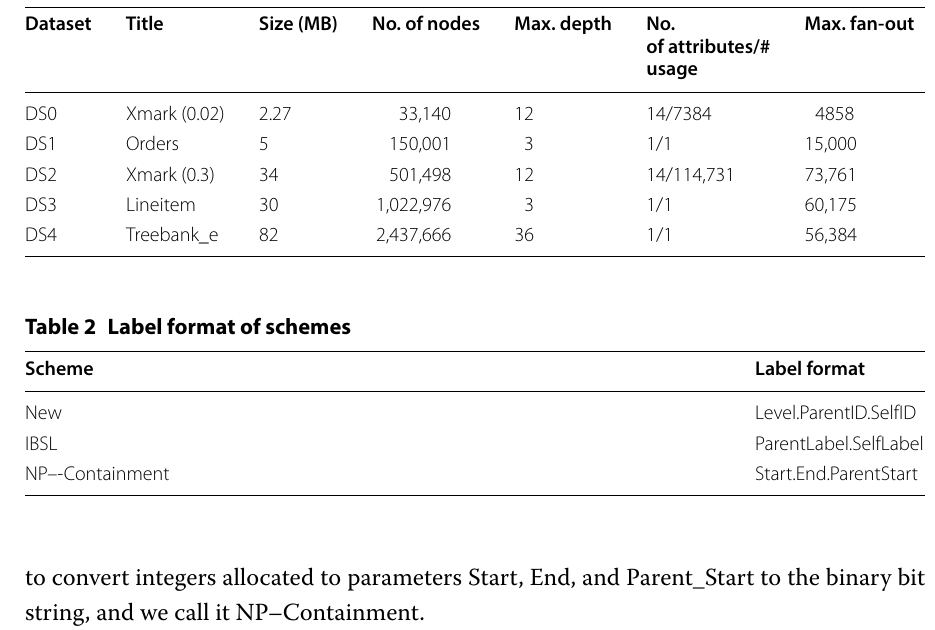
Table 1 Characteristics of the datasets